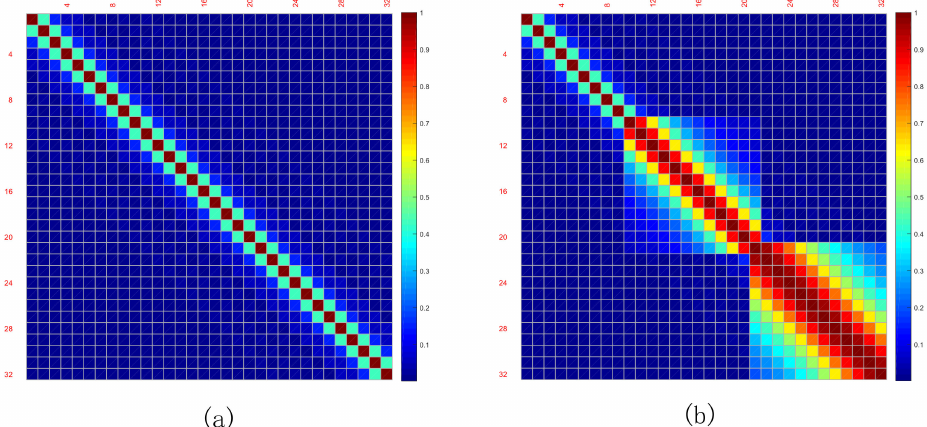
Figure 5. Stationary and nonstationary channel correlation matrix. ( a ) The WSSUS correlation matrix; ( b ) the non-WSSUS correlation